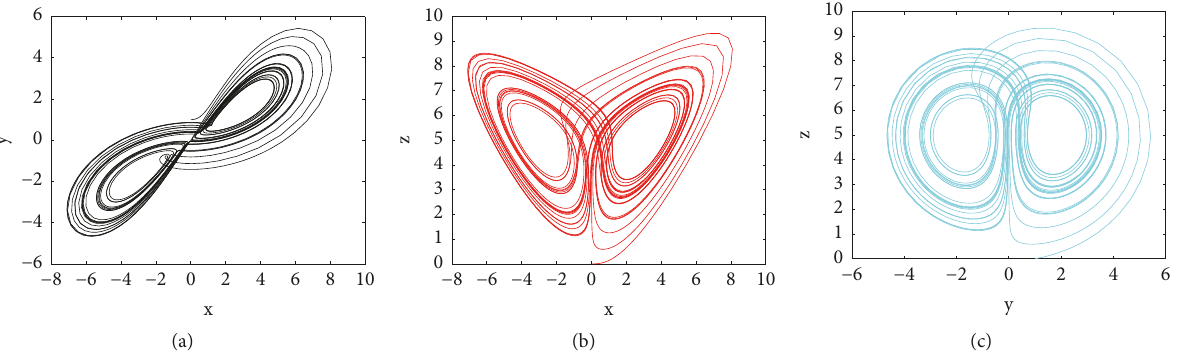
Figure 4: Strange attractors of chaotic system for Experiment 2 at 𝑏 = 1 : (a) (𝑥,𝑦) -plane; (b) (𝑥,𝑧) -plane; (c) (𝑦,𝑧) -plane.